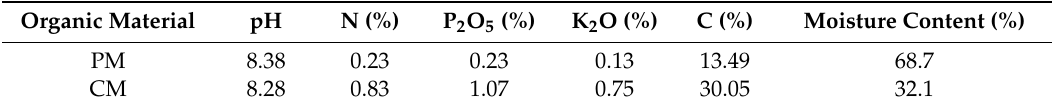
Table 2. Physical and chemical properties of the organic